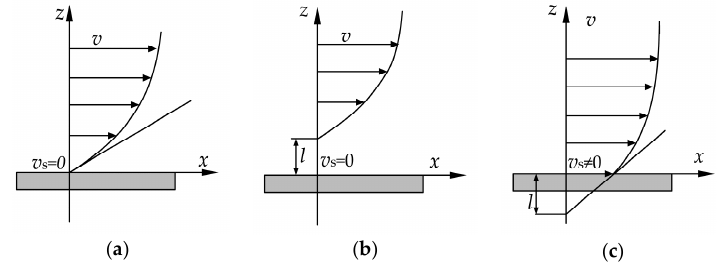
Figure 1. Slip boundary model ( a ) non-slip; ( b ) negative slip; ( c ) positive slip.